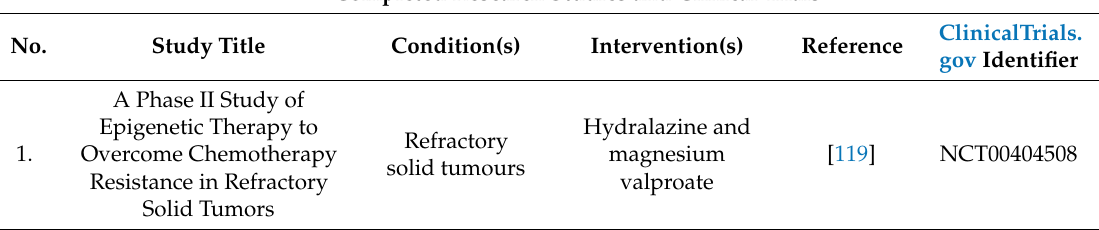
Table 1. A list of completed research studies and clinical trials relating to the topic, arranged in alphabetical